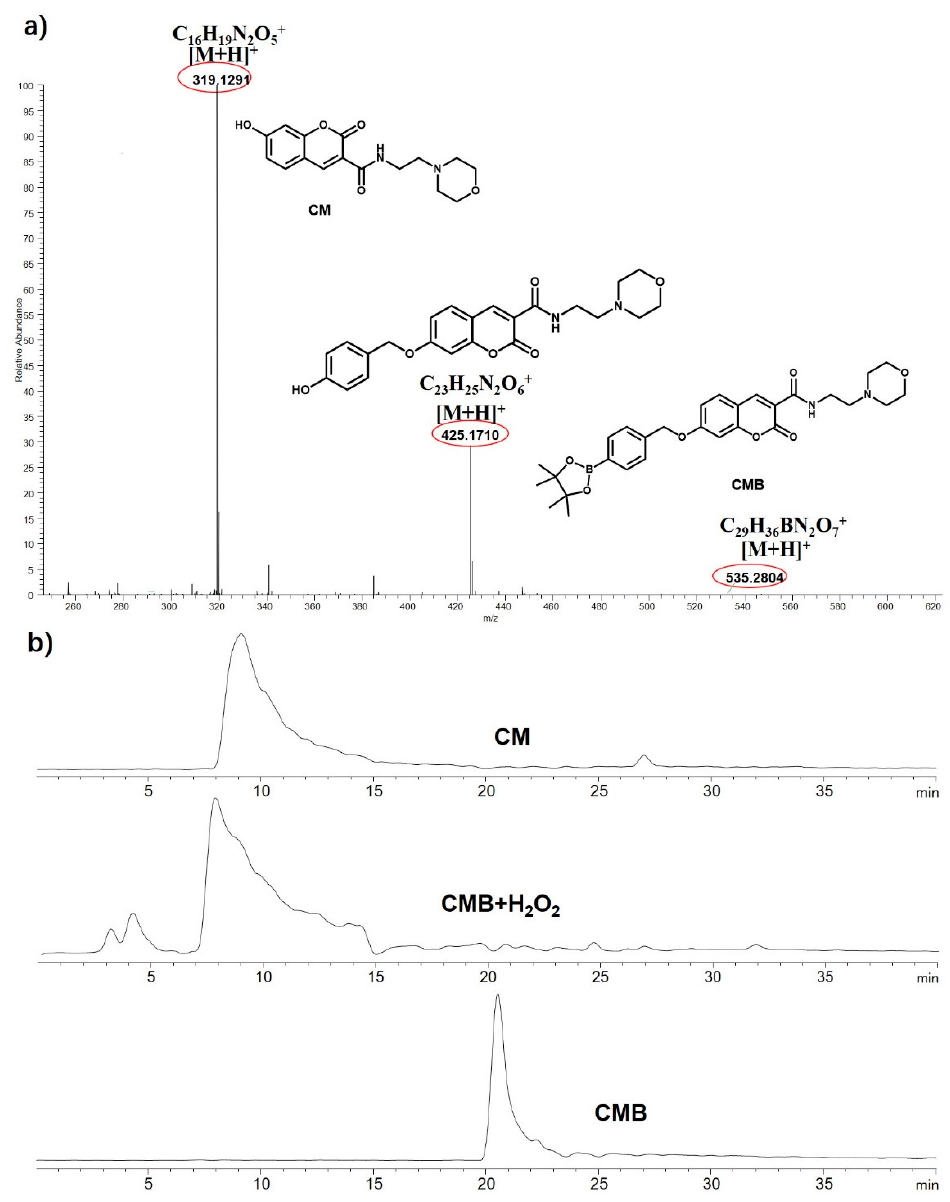
Figure 3. ( a ) HRMS of CMB after adding H 2 O 2 . ( b ) Liquid chromatography of CMB, CMB treated with H 2 O 2 , and CM .